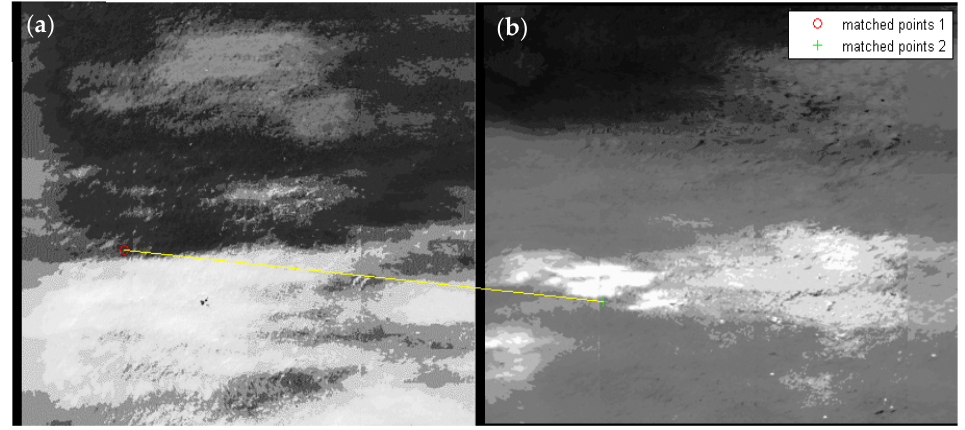
Figure 9. The error result of ocean image feature matching. ( a , b ) are the distributions of image feature points at different times.